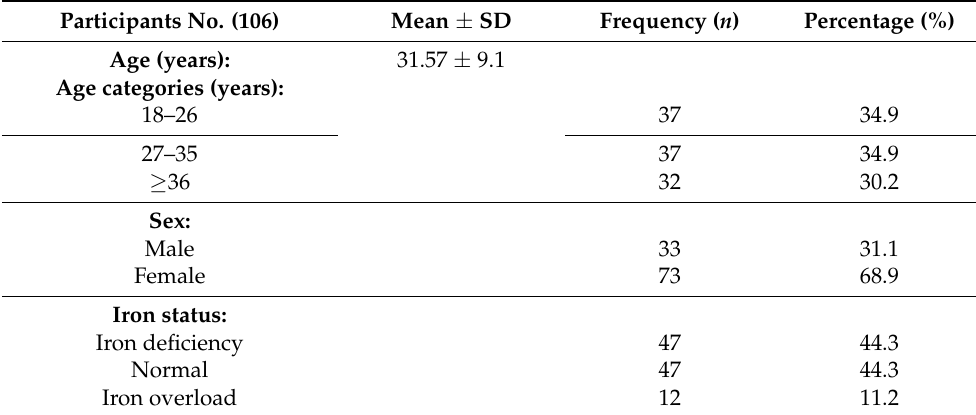
Table 2. Baseline characteristics of the participants.